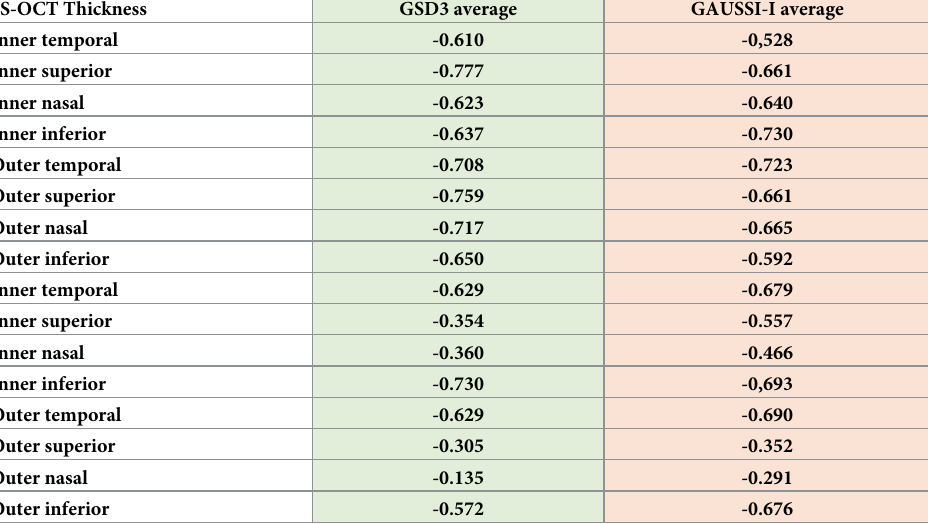
Table 5. Correlation coefficient (r) between severity score and retinal or choroidal thickness by SS-OCT. [Weak correlation (0.20–0.39); Moderate correlation (0.40–0.69); Strong correlation (0.70–0.99)], (p <